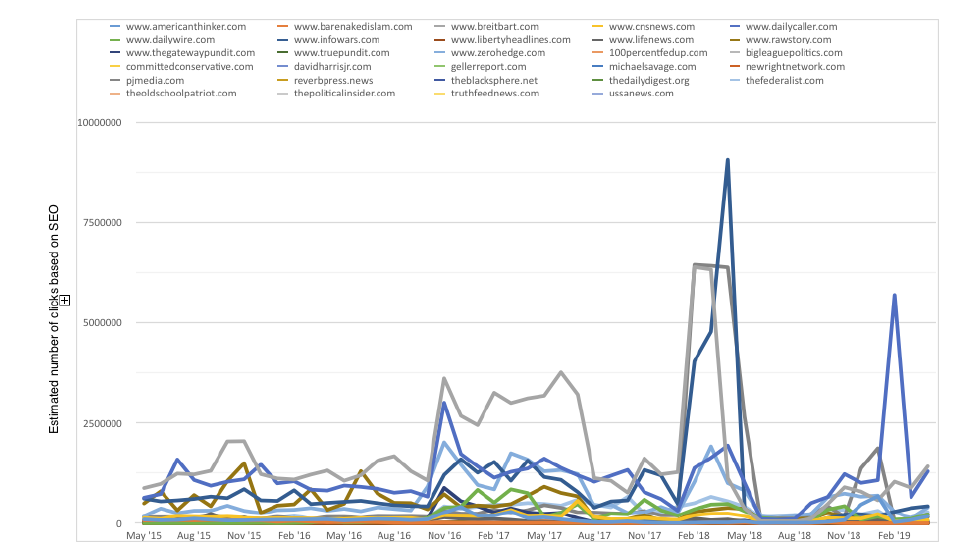
Figure 5: Estimated organic clicks for the top 29 junk news domains (May 2015-April